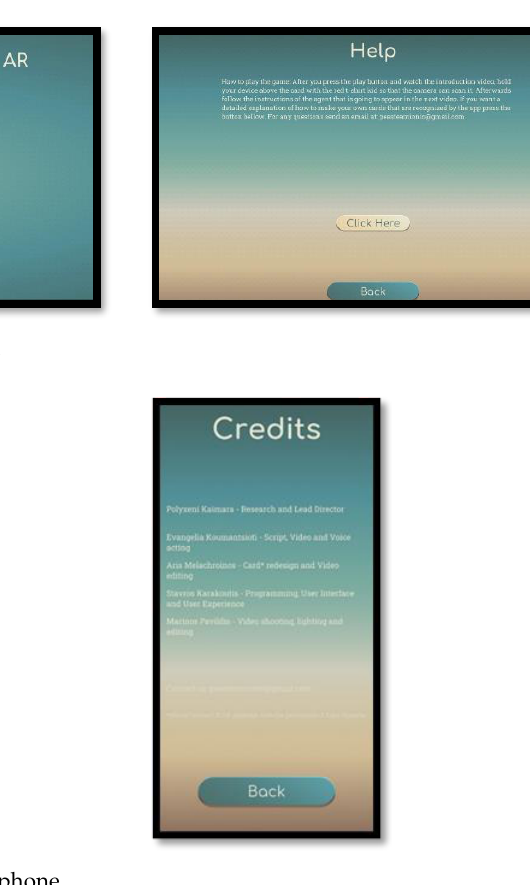
Figure 25. WUIM-AR UI for smartphone.